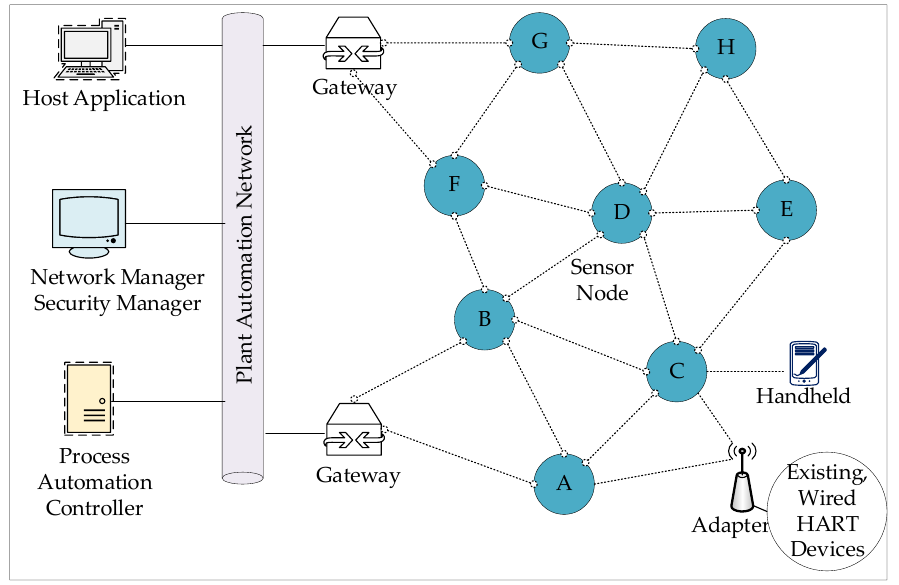
Figure 1. WirelessHART mesh network